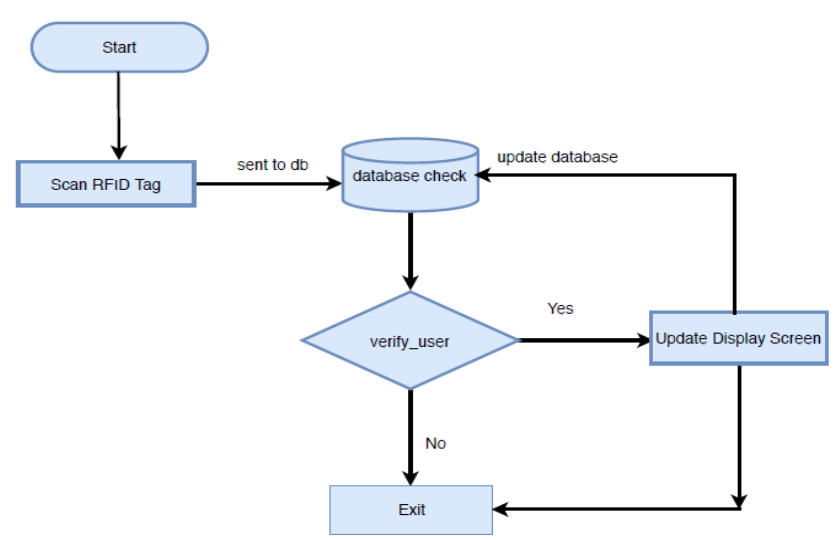
Fig 1.4. Flow chart of the proposed